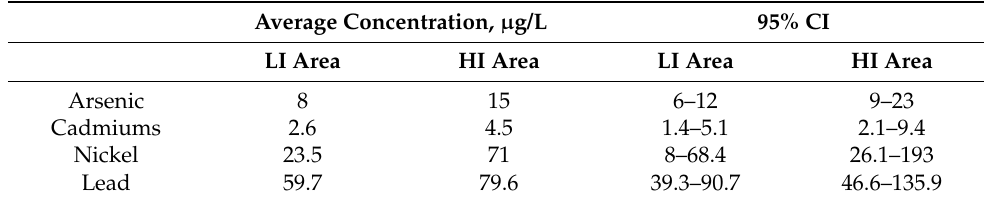
Table 2. Heavy metals metrics.